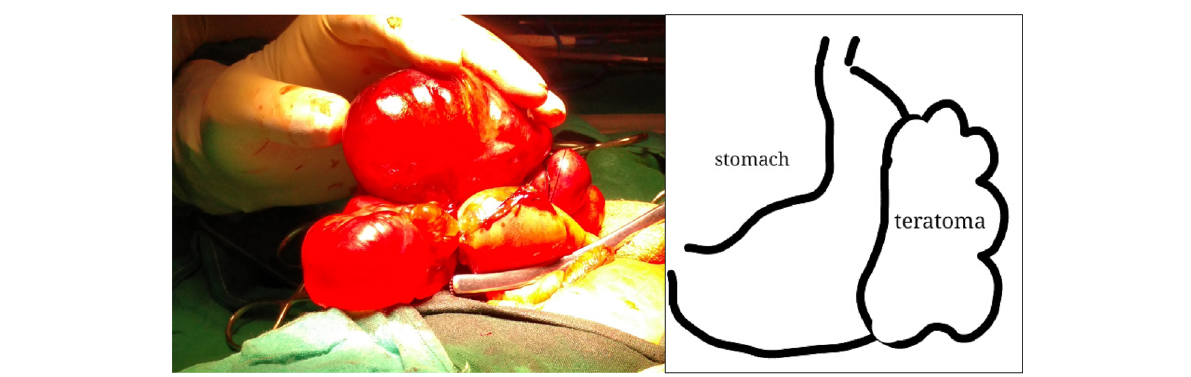
Fig. 2 After stabilizing the neonate, exploratory laparotomy was performed on the seventh day of life which revealed a large solid-cystic mass 9.5 cm × 5 cm × 3 cm arising from postero-inferior wall of the stomach along its greater